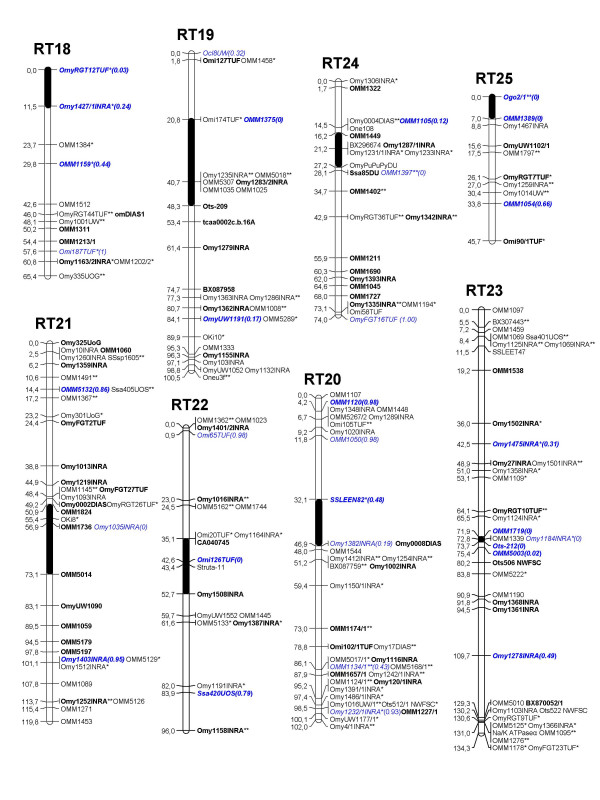
Graphic representation of linkage groups RT18 to RT25. Legends are the same as in Figure 1.